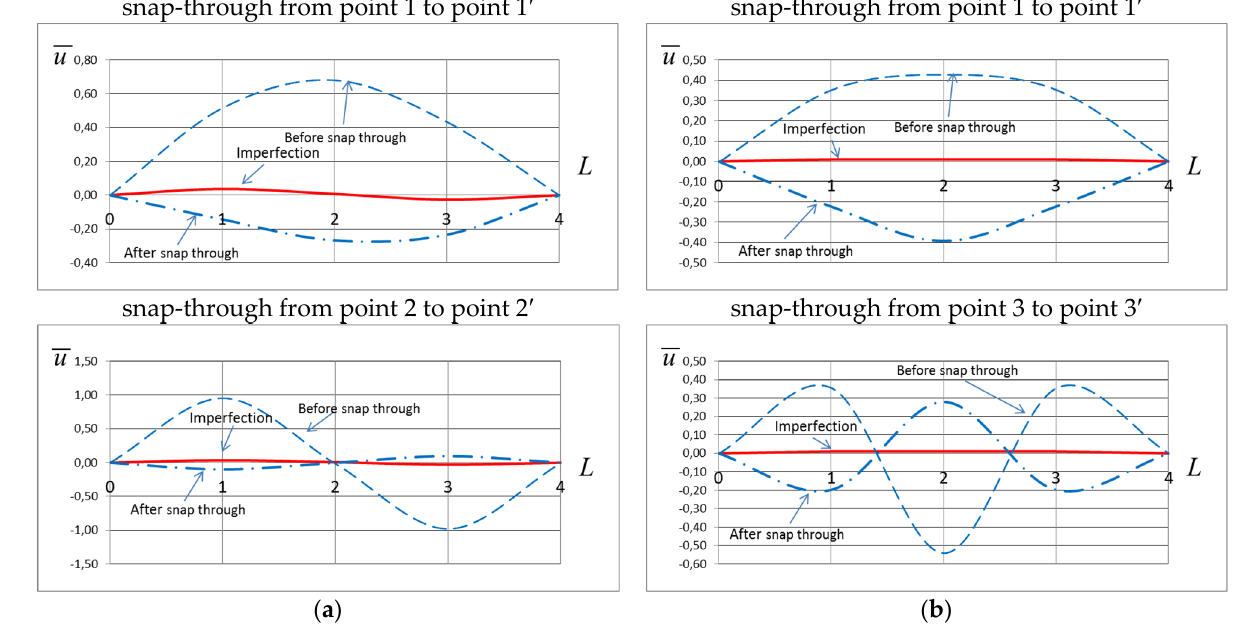
Figure 17. Configuration of displacement before and after snap-through for initial amplitudes of geometrical imperfections developed according to the first and second or third buckling mode; ( a ) m 1 s 2, ( b ) m 1 s 3.